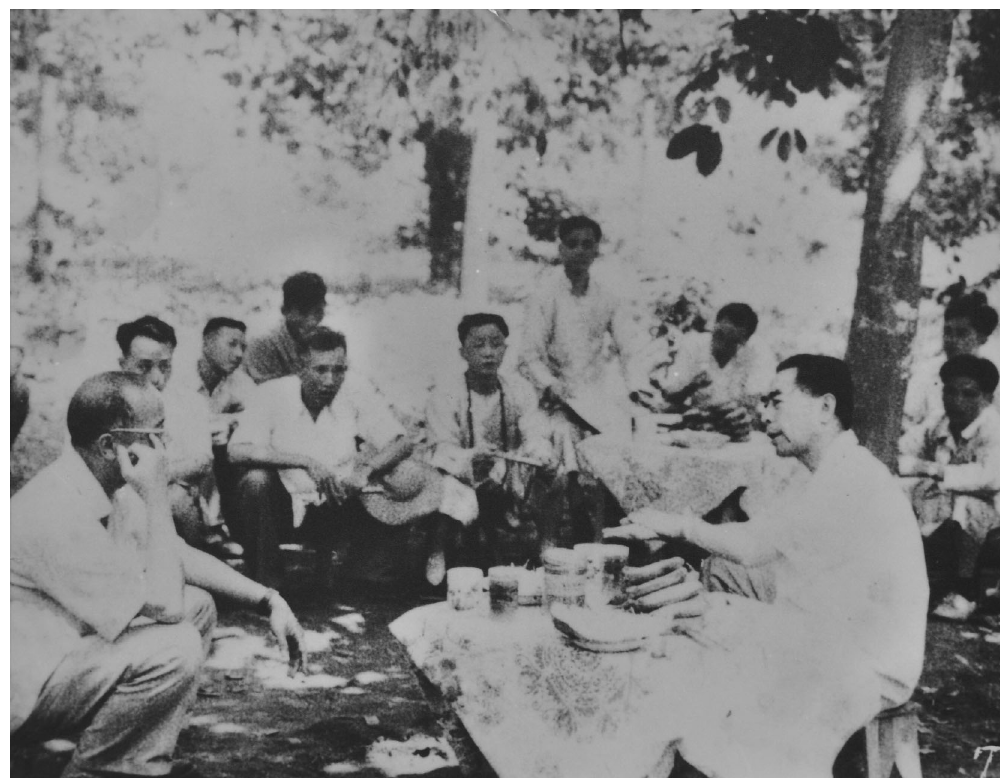
Figure 4. Premier Zhou Enlai had a cordial talk with Mr. Cai (right) under rubber forest in